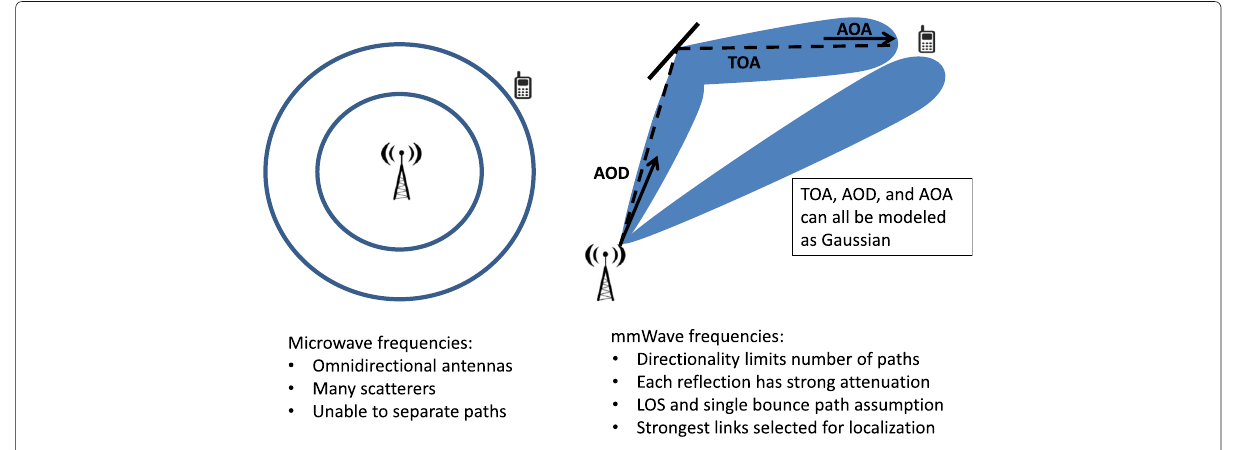
Fig. 1 Signal propagation in microwave and mmWave